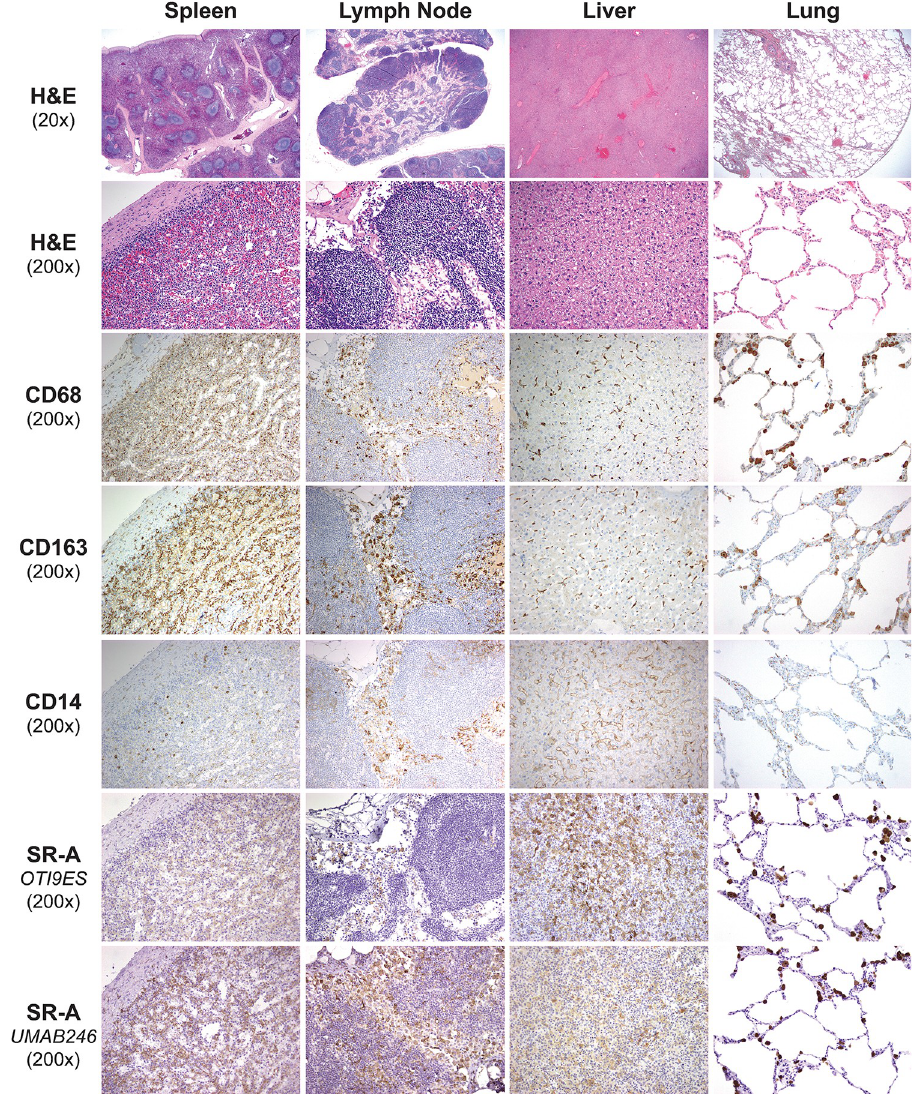
Fig 3. Expression pattern of monocyte/macrophage markers in spleen, lymph node, liver, and lung. Shown are representative H&E and immunostaining patterns of resident tissue monocyte/macrophages in FFPE sections of spleen, lymph node, liver, and lung. SR-A staining (OTI9ES and UMAB246) shows a similar pattern to CD68 and CD163 in the splenic cords and sinus histiocytes (lymph nodes), Kuppfer cells (liver) and alveolar macrophages (lung). CD14 staining was different from the other macrophages markers in splenic red pulp cords, Kuppfer cells (liver), and alveolar macrophages (lung).